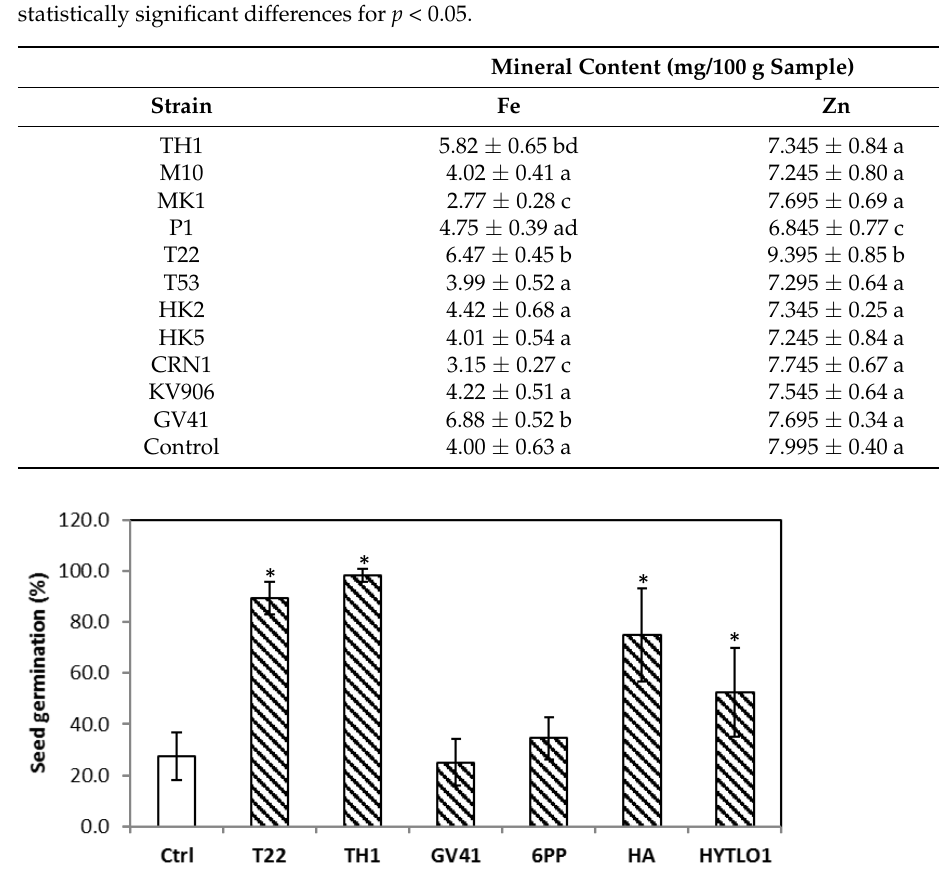
Figure 4. Effect of the seed treatment with Trichoderma strains (T22, TH1, GV41) or metabolites (6PP, HA, HYTLO1) on the germination of lentil seeds cv. CDC MAXIM CL (3 days after the treatment). Water treatments served as controls (Ctrl). Asterisks indicate significant differences ( p < 0.05) compared with the control. Statistical analysis was carried out using the one-way ANOVA.